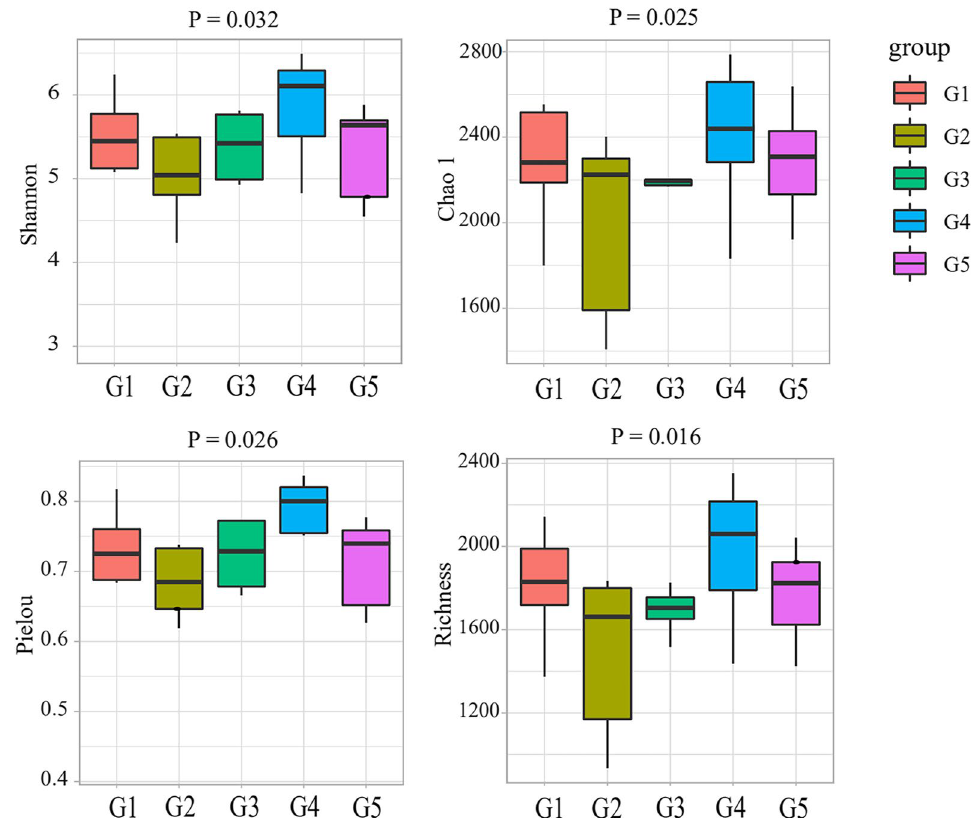
Fig. 4 Alpha diversity indices of bacterial communities in five groups. Alpha diversity indices include Shannon diversity, Chao 1 richness, Pielou, and Richness. P-value was caculated based on one-way ANOVA with LSD multiple